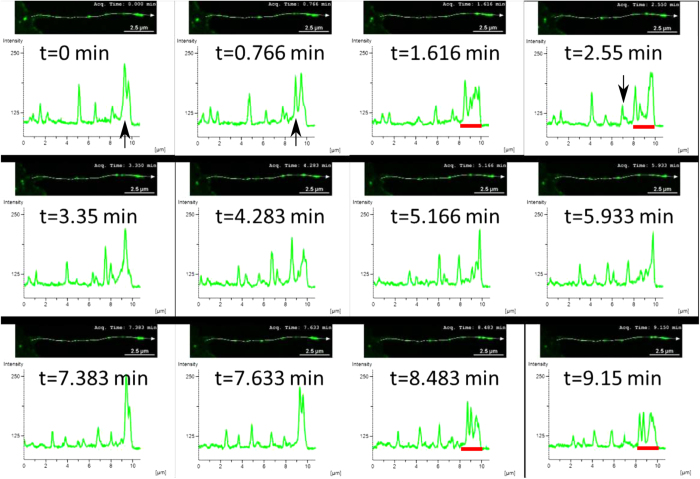
As in Fig. 2, but for relatively long filopodia (~10 μm).Pulses that originate at the tip are indicated by black arrows, and the cases showing tip-accumulation mechanism are indicated by red bar.